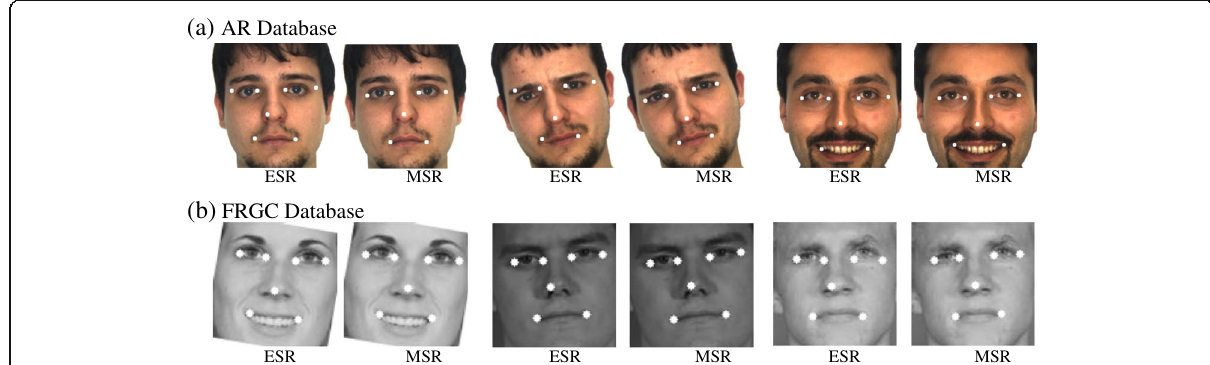
Fig. 16 Face alignment results (seven landmarks) achieved by ESR and MSR methods. a AR database. b FRGC database